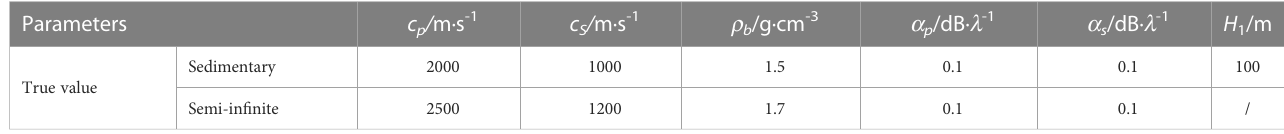
TABLE 1 Parameters used for the simulation of the sea environment.